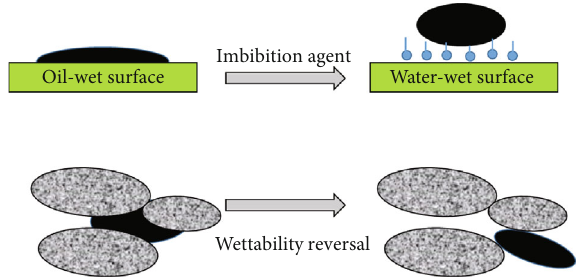
Figure 8: Schematic of wettability reversal mechanism for enhanced oil recovery (EOR).